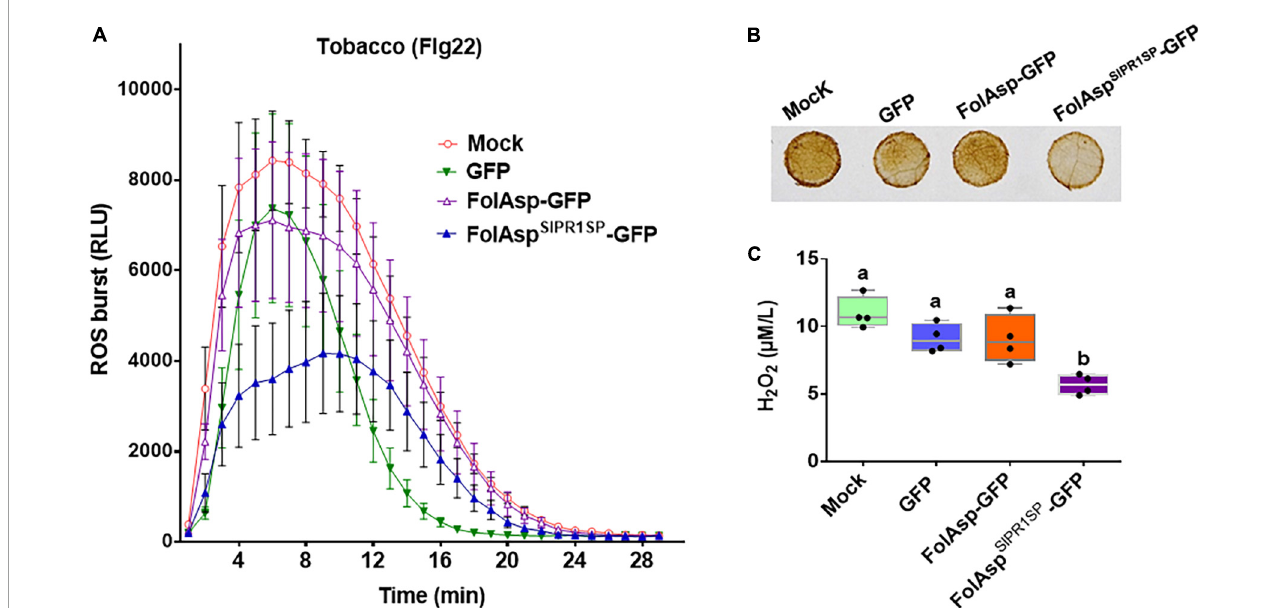
FIGURE6 FolAsp inhibits ROS production. (A) Burst of ROS in GFP, FolAsp-GFP, or FolAsp SlPR1 SP -GFP transiently expressed tobacco leaves was measured with 50 nM flg22. Mean values ( ± SEM) of eight replicates are shown. (B) FolAsp inhibits leaf H 2 O 2 production induced by flg22. The GFP, FolAsp-GFP, or FolAsp SlPR1 SP -GFP transiently expressed tobacco leaves and the control leaves (Mock) were treated with the DAB following 50 nM flg22 treatment for 30 min to visualize H 2 O 2 accumulation. (C) Quantification of H 2 O 2 was measured with samples from (B) . Statistical significance was revealed by one-way ANOVA (mean ± SE of 3 independent biological replicates, p < 0.05). Experiments were repeated three times with similar